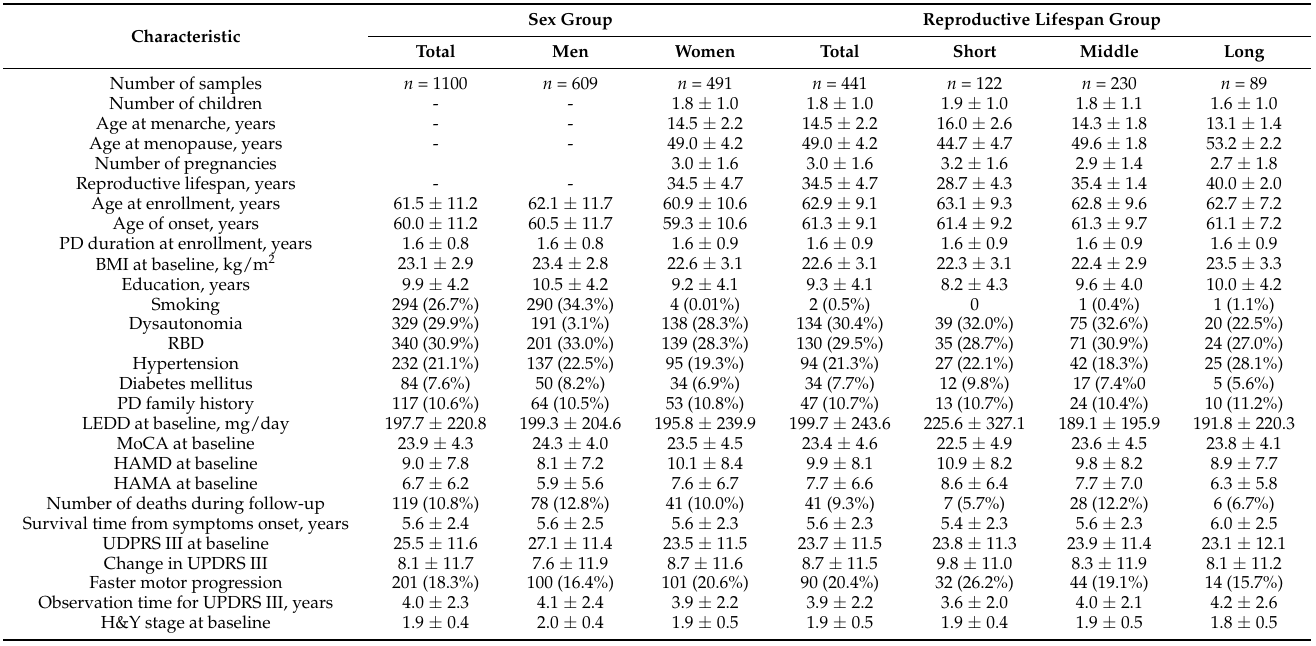
Table 1. Baseline and outcome characteristics of the follow-up cohort. Sex Group Reproductive Lifespan Group Characteristic Total Men Women Total Short Middle Number of